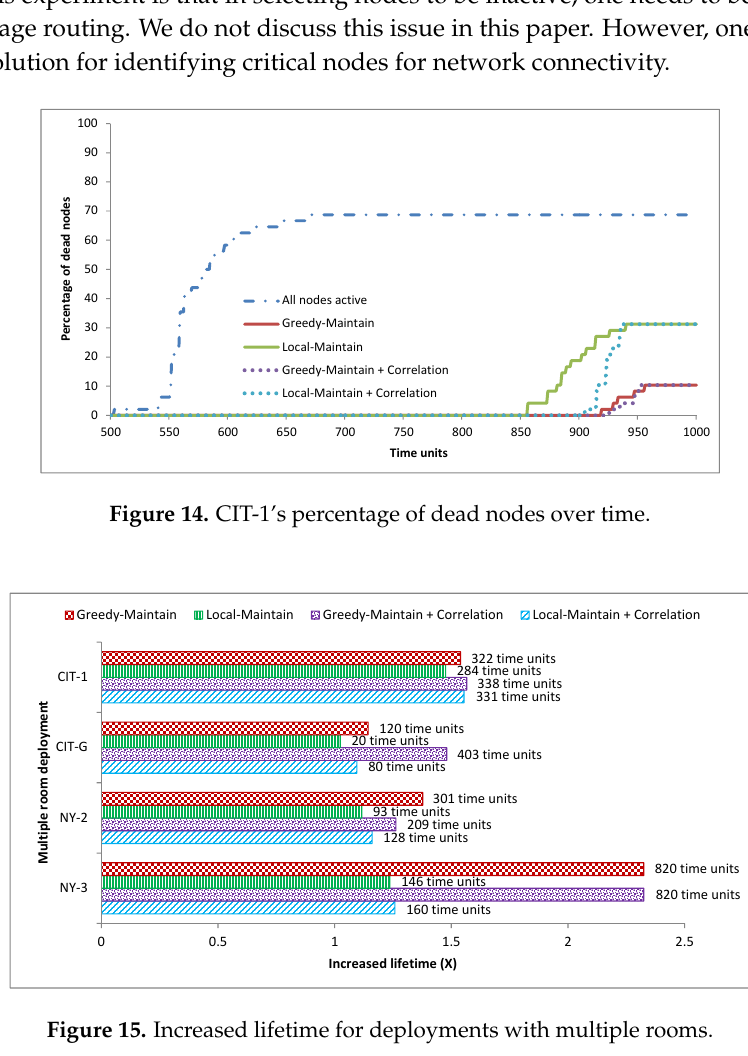
Figure 15. Increased lifetime for deployments with multiple